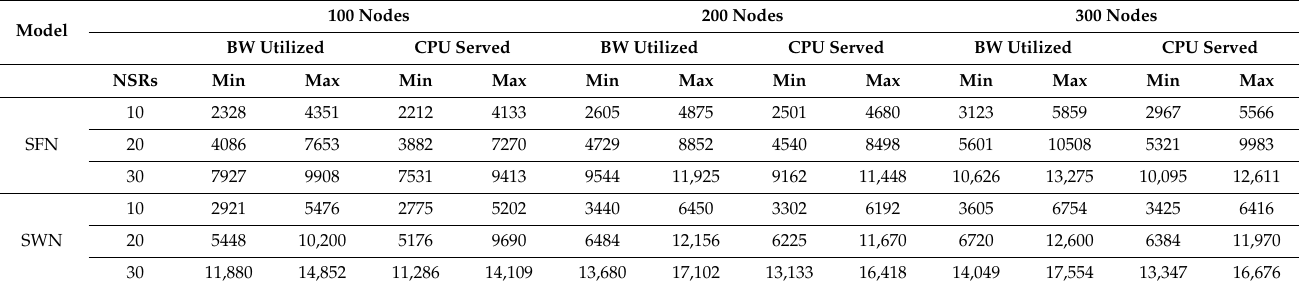
Table 4. Performance comparison with LT NSR [ LT min = 10, LT max =